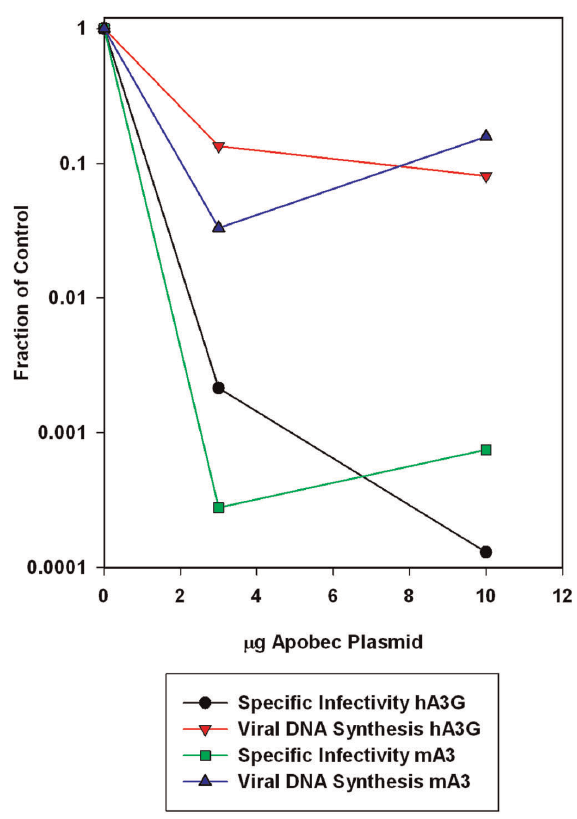
Figure 5. Effect of APOBEC3s on D Vif HIV-1 DNA synthesis. 293- mCAT1 cells were infected with D Vif HIV-1. Infectivity and RT activity were assayed as described [25,29,30]. Twenty-four hours after infection, the cells were lysed and assayed by real-time PCR for Luciferase DNA (black and green lines) as described in Materials and Methods [32]. Specific infectivity is represented with red and blue lines. doi:10.1371/journal.pone.0038190.g005 stages of viral DNA synthesis. In contrast, restriction of MLVs by hA3G and of D Vif HIV-1 by mA3 is not at the level of DNA